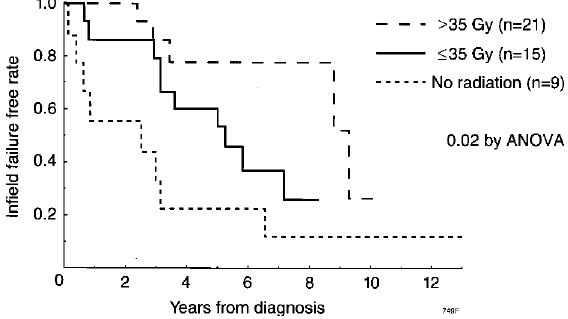
Fig. 3. Effect of post-operative radiation on time to recurrence in RPS. The proportion of patients remaining free of infield recurrence from the time of diagnosis is shown for 45 patients with RPS treated with grossly complete resection and post-oper- ative external beam radiation. Patients are grouped according to the dose of radiation given, as indicated (from Reference 19, reproduced with